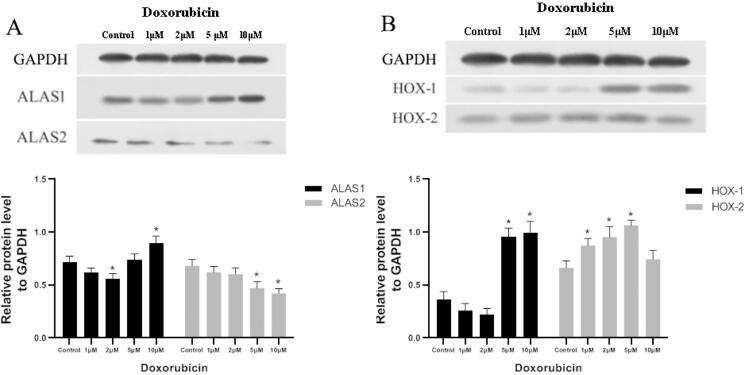
– Analysis data of western blotting for ALAS (A) and HOX (B) protein level change in H9c2 cells at different concentrations for doxorubicin. ALAS1, aminolaevulinic acid synthase 1; ALAS2, aminolaevulinic acid synthase; HOX-1, heme oxygenase 1; HOX-2, heme oxygenase 2. Each western blot was conducted three times. * indicate p<0.01 vs. control group.